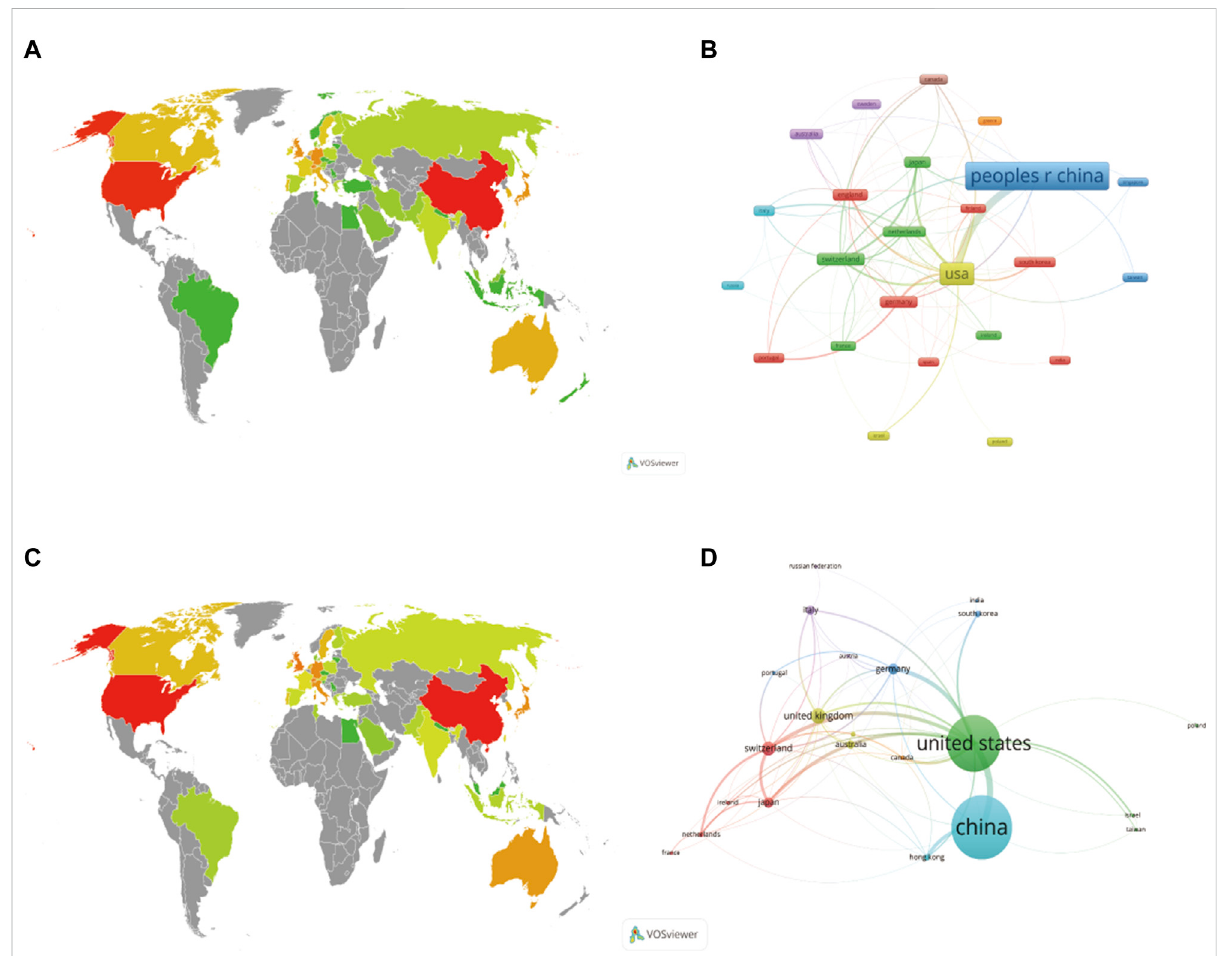
FIGURE 3 Global distribution of national publications in WOSCC (A) and Scopus (C) . The darker the colour, the greater the volume of literature, with both theChina and USpanels inred on theworld map, indicating thehighestvolume ofpublications. Cooperation networksbetweencountries/region in WOSCC (B) and Scopus (D) . Different colours represented different categories, while countries cooperated with each other by linking lines, with thicker connections implying closer cooperation. A node represented a region, with larger segments indicating more national issuance. The graph illustrated that although China has a higher volume of publications, the US cooperated more closely with other countries in international